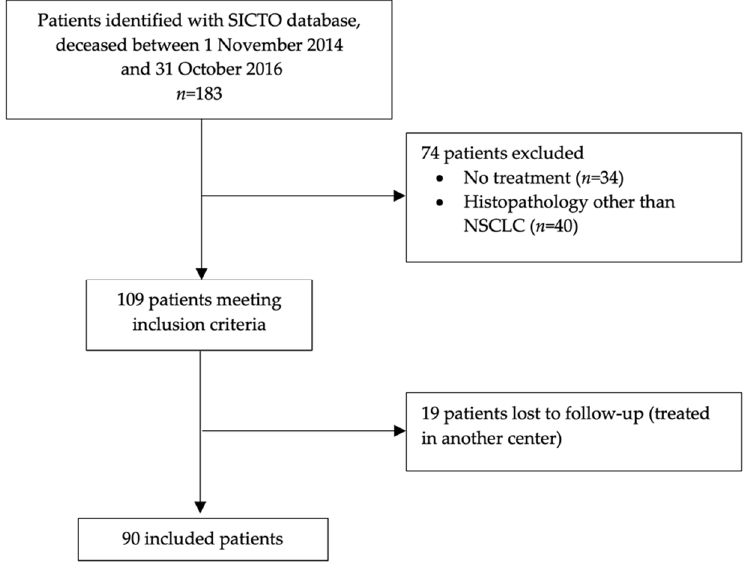
Figure 1. Patient-flow diagram.